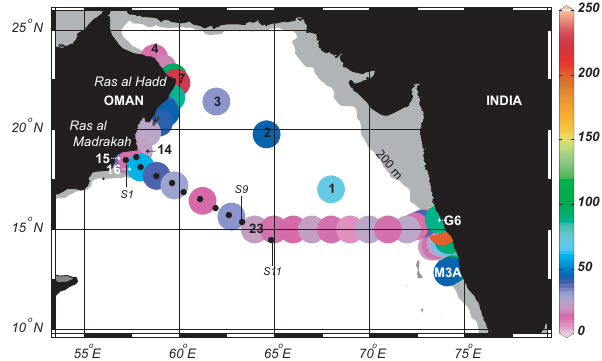
Fig. 1. Locations of sampling stations (large coloured circles) with the colour indicating the integrated chlorophyll- a inventory (mgm − 2 ) based on observations on Cruises SK208 and SK209. Inventories are to a depth of 100m or to the last sampling depth at shallower stations. Smaller black circles represent